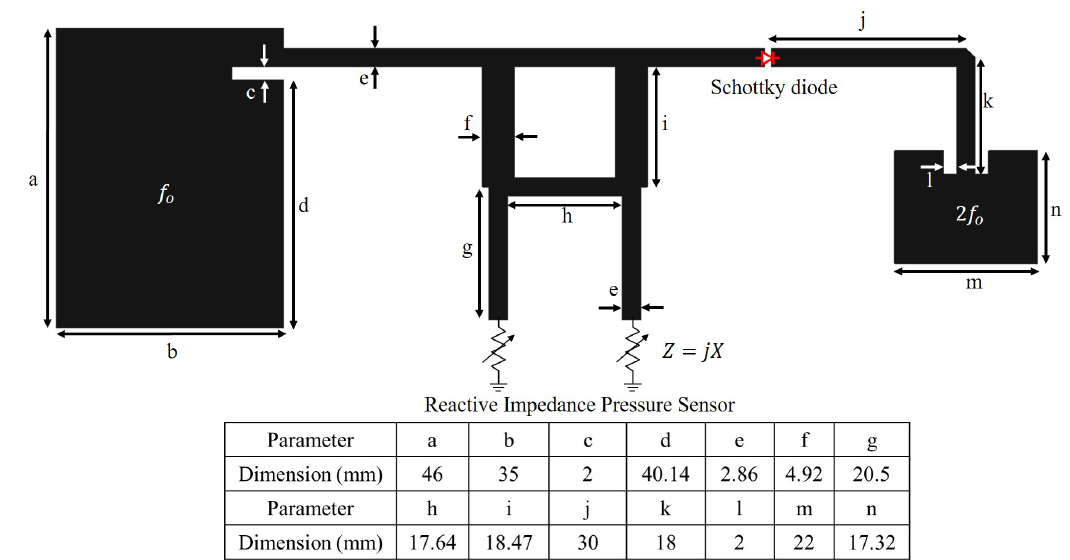
Figure 7. Schematic of the pressure sensing harmonic RF tag along with its dimensions. Signal received using 2 GHz antenna forwarded to the hybrid coupler for phase shift according to the integrated pressure sensor and the second harmonic signal with double shifted phase, generated using diode frequency doubler, is transmitted out using 4 GHz patch antenna.